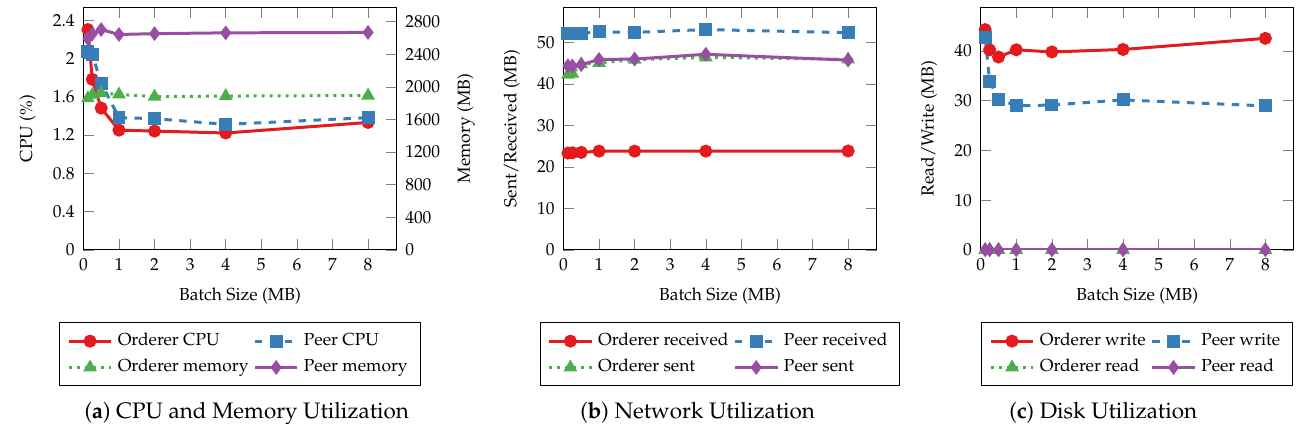
Figure 14. The average CPU and memory usage ( a ), total data received from and sent to the network ( b ), total data written to and read from disk ( c ) of orderer and peer nodes for handling “requesting for service” operations with varying batch sizes.